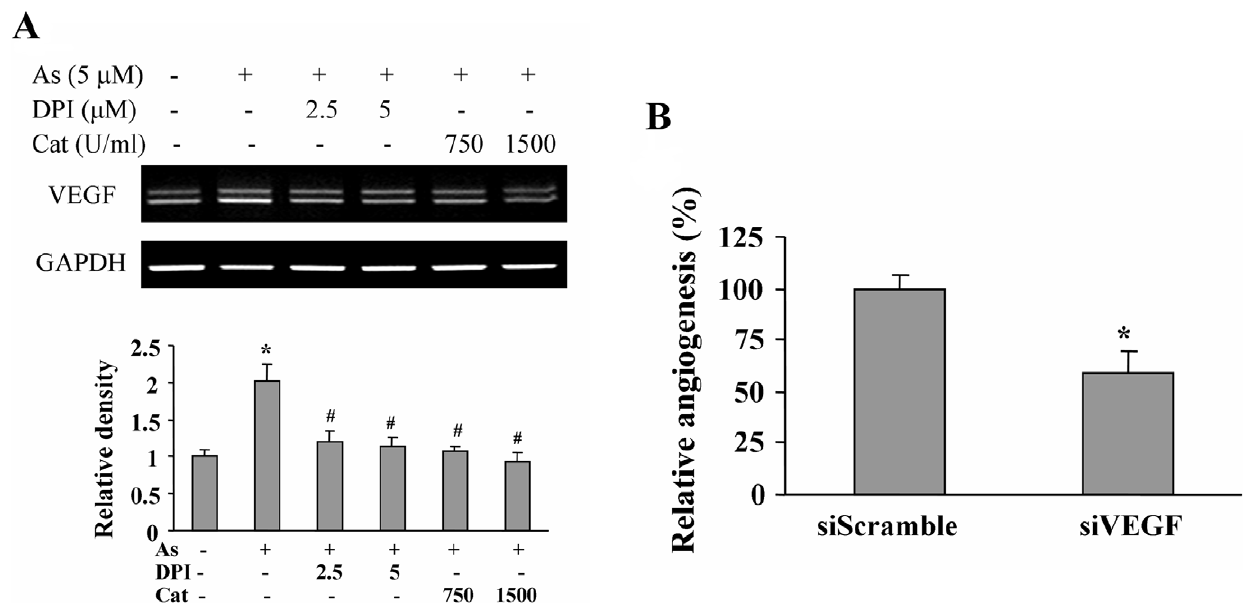
Figure 6. VEGF is required for arsenic-inducing angiogenesis . (A) BEAS-2B cells were treated with DPI or catalase for 30 min, then with 5 m M arsenic for 24 h. Total RNAs were extracted by Trizol, and analyzed by RT-PCR for VEGF and GAPDH expression (upper panel). Relative density of VEGF was analyzed by the ratio of VEGF/GAPDH using ImageJ software and normalized to control cells. The data represents the mean 6 SD from duplicate experiments (bottom panel). *, indicates significant increase when compared with the control cells, P , 0.05. . # , indicates significant decrease when compared with the sodium arsenite treatment alone, P , 0.05. (B) BEAS-2B cells were transfected with VEGF siRNA and scrambled siRNA (siVEGF and siScramble, respectively). After the transfection for 24 h, cells were treated with 5 m M arsenic for 5 h to perform angiogenesis assay. *, indicates that the relative angiogenesis index was significantly decreased in siVEGF treatment group when compared with siScramble group, P , 0.05.